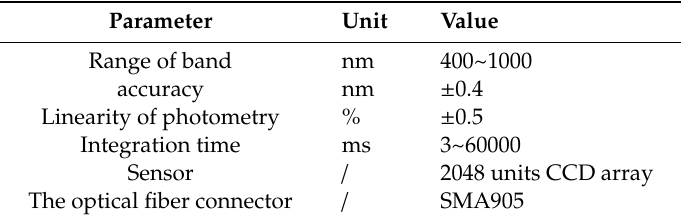
Table 4. Main specifications of EU2000+ spectrometer.